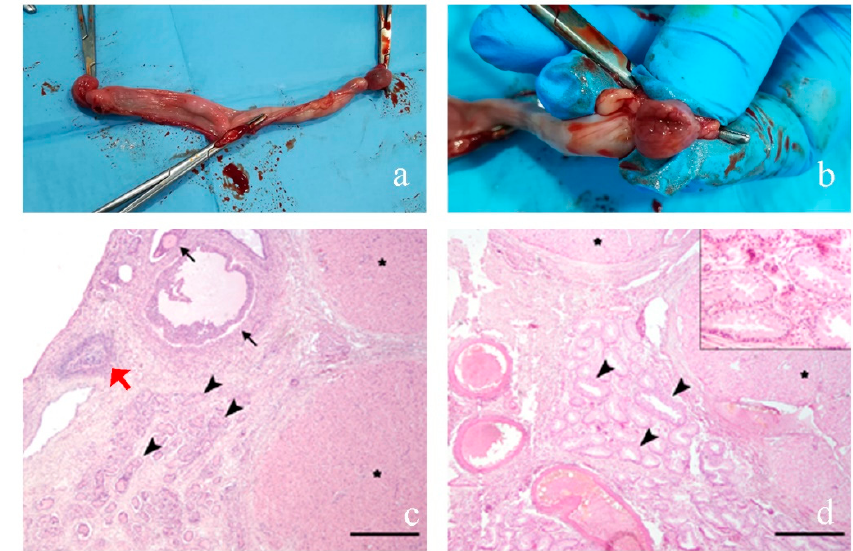
Figure 4. Genital apparatus surgically removed in Case 4. ( a ) A well-developed uterus and ( b ) section of gonads; ( c ) ovarian tissue composed of numerous follicles in various stages of development (black arrows), rare atretic follicles (red arrow) associated with few corpora lutea (asterisks) and, more deeply located, curvy seminiferous tubules (arrowhead), supported by abundant ovarian stroma; ( d ) testicular tissue composed of curvy seminiferous tubules (arrowhead) associated with two corpora lutea (asterisk) supported by a moderate amount of dense fibrous stroma with medium- and large- sized blood vessels. Insert: seminiferous tubules are lined by one layer of Sertoli cells extending from the basement membrane and protruding into the lumen and diffusely lack germ cells (hypoplasia). Interlaced with seminiferous tubules there are rare groups of Leydig cells. Hematoxylin–eosin (HE) staining. Scale bars = 500 μ